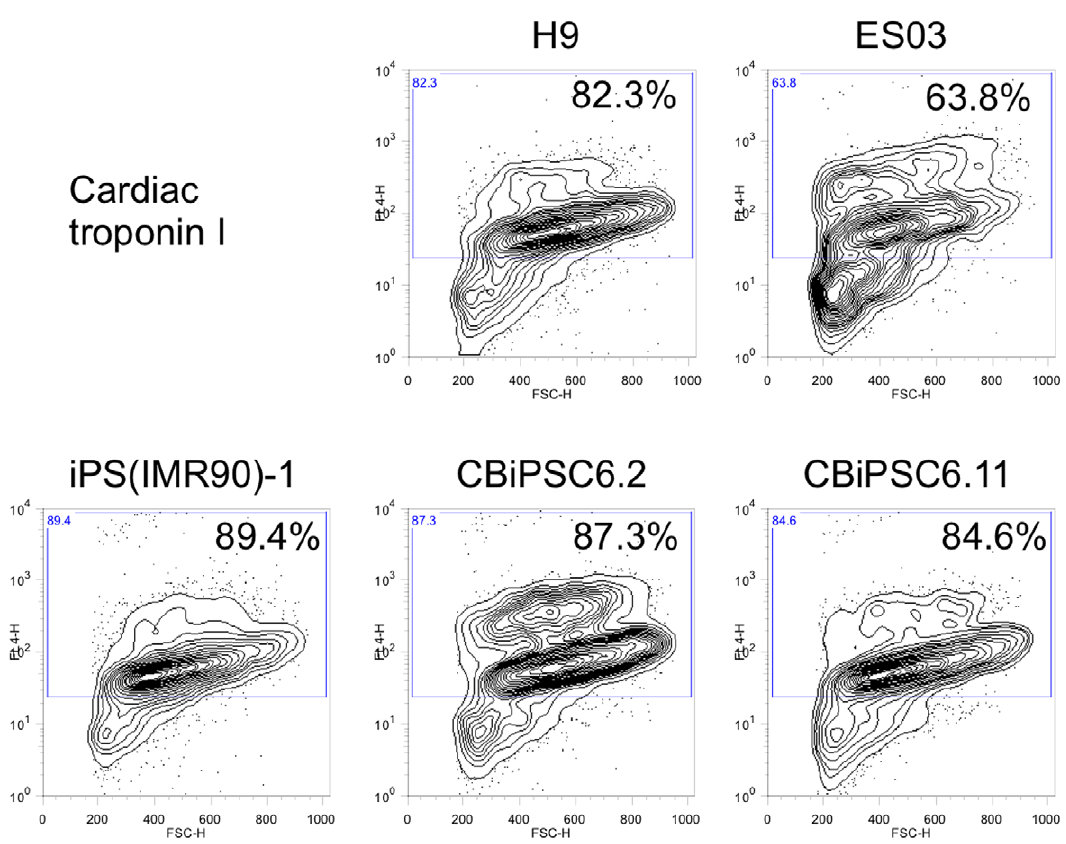
Figure 6. Intracytoplasmic flow cytometry analysis of cardiomyocyte marker expression. Expression of cardiac troponin I in contracting hEB from differentiated H9 hESC, ES03 hESC, viral fibroblast-derived line iPS(IMR90)-1 hiPSC, and non-viral CD34 + cord blood-derived hiPSC lines CBiPSC6.2 and CBiPSC6.11. For each sample the entire U-well contents of one 96-well plate was enzymatically digested into a single cell suspension and analyzed by flow cytometry.